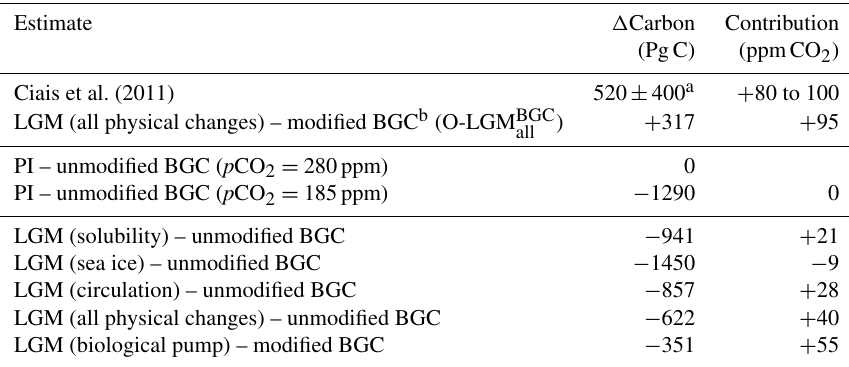
Table 4. A summary of the total changes in ocean carbon storage and their drivers between our simulated pre-industrial (PI) and Last Glacial Maximum (LGM) climates. We use the increase in carbon of our O-LGM BGC experiment of 317PgC, which falls within the estimate range all of ocean carbon storage at the LGM (Ciais et al., 2011), and our simulated loss of 1290PgC from the PI ocean with an atmospheric p CO 2 of 185ppm to determine the contribution of physical and biogeochemical drivers in ppm of CO 2 . For example, an addition of 1607PgC in excess of experiment O-PI LGM ( + 317PgC in column 2) would constitute a contribution of 95ppm. BGC refers to CO 2